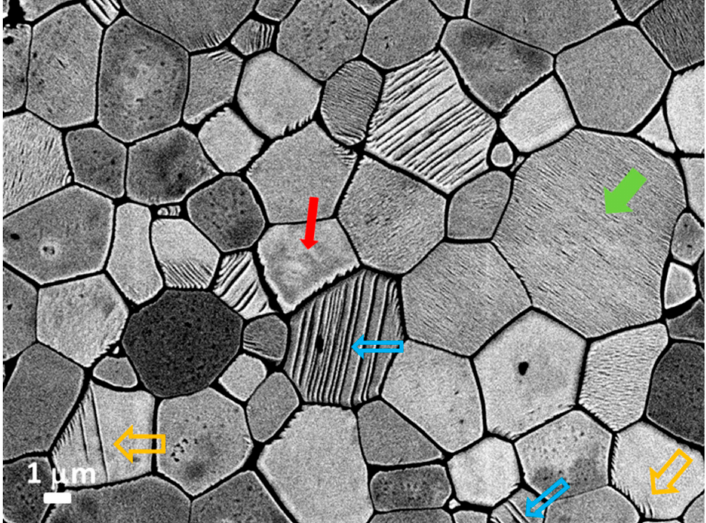
Figure 4. FE-SEM micrograph of polished and thermally etched surface of PFN sample showing micro-sized wedge (thick open orange arrows), irregularly shaped (thin solid red arrow), and lamellar-like (thin open blue arrows) domains. Domains, a few hundred nanometres in size (thick solid green arrow), are also